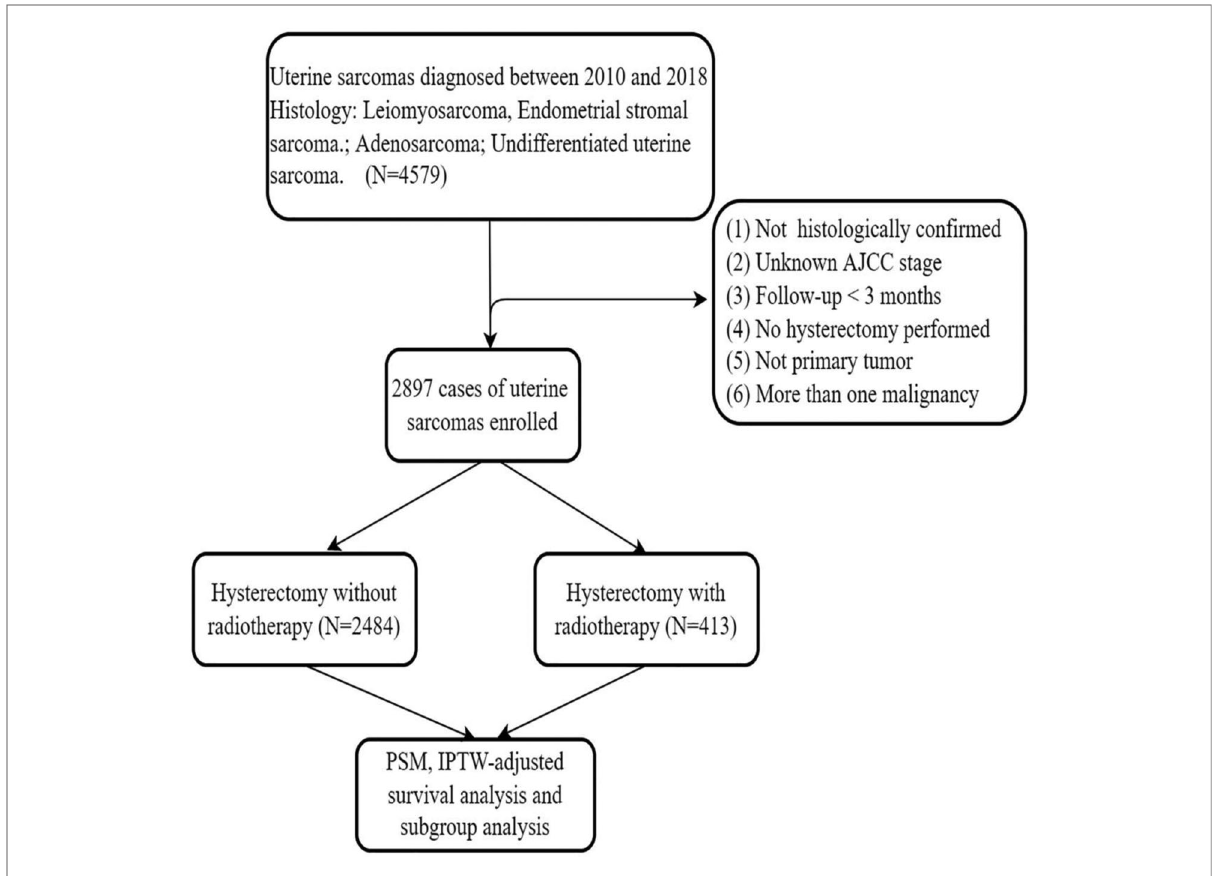
FIGURE 1 Eligibility, inclusion, and exclusion criteria of the study